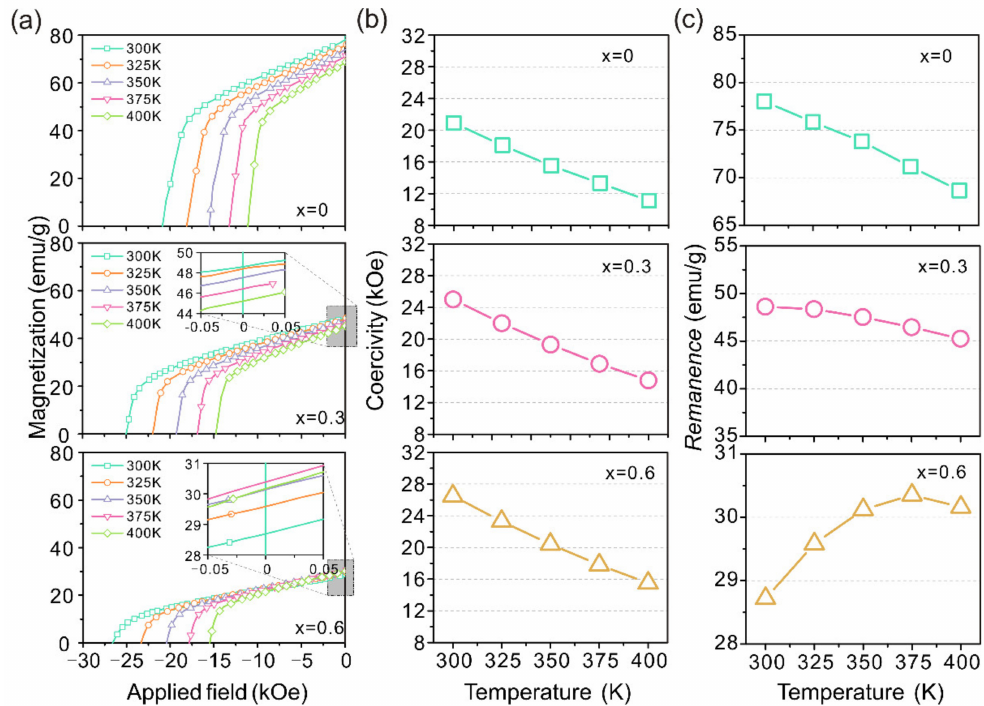
Figure 3. Temperature-dependent magnetic properties of NPHFBM alloys with x = 0, 0.3 and 0.6. ( a ) Demagnetization curves. ( b ) Coercivity. ( c )